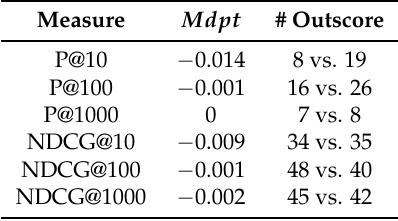
Table 27. T2: comparison of the best run vs. the RR fusion of the two best runs. Measure Mdpt # Outscore P@10 − 0.016 11 vs. 25 P@100